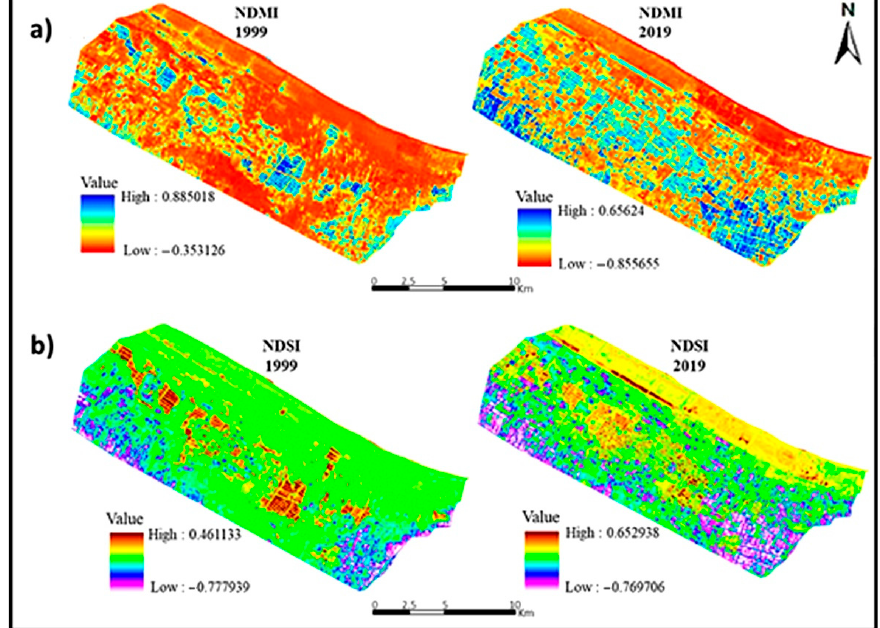
Figure 7. ( a ) Spatial distribution maps of NDMI, ( b ) spatial distribution maps of NDSI; for Deltaic Mediterranean Coast of the study area.